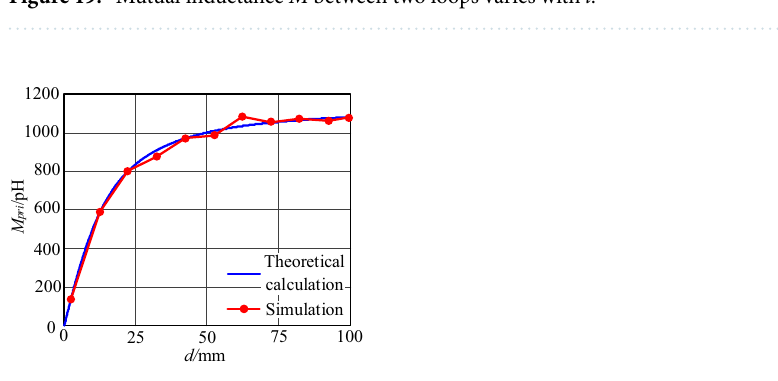
Figure 19. Mutual inductance M between two loops varies with l .